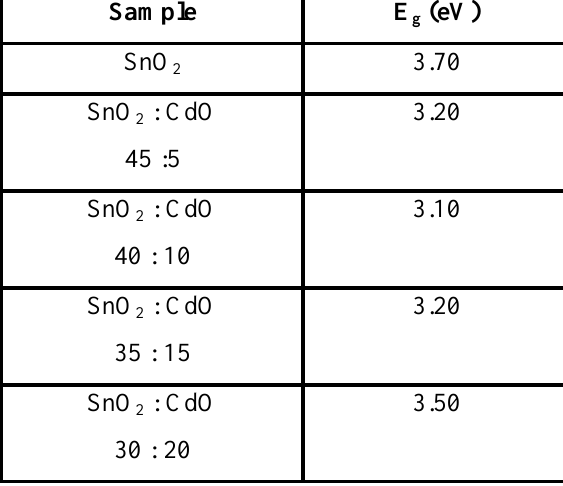
Table 3: Eg opt variation with CdO at different